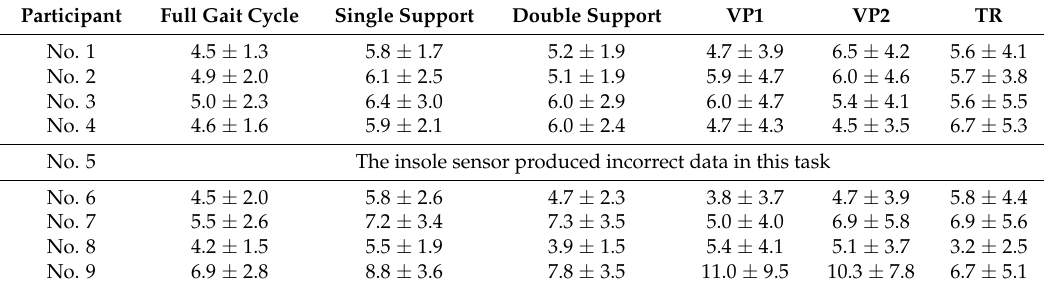
Table 3. Mean and SD of prediction errors for OFW (rRMSE %) based on L5 acceleration.